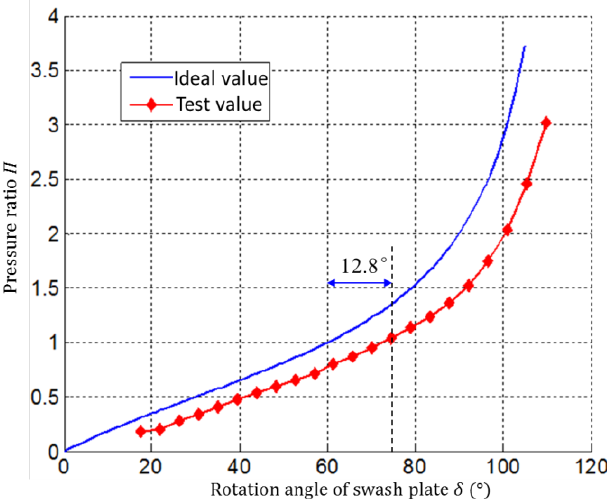
Figure 7. Comparison of pressure ratio.